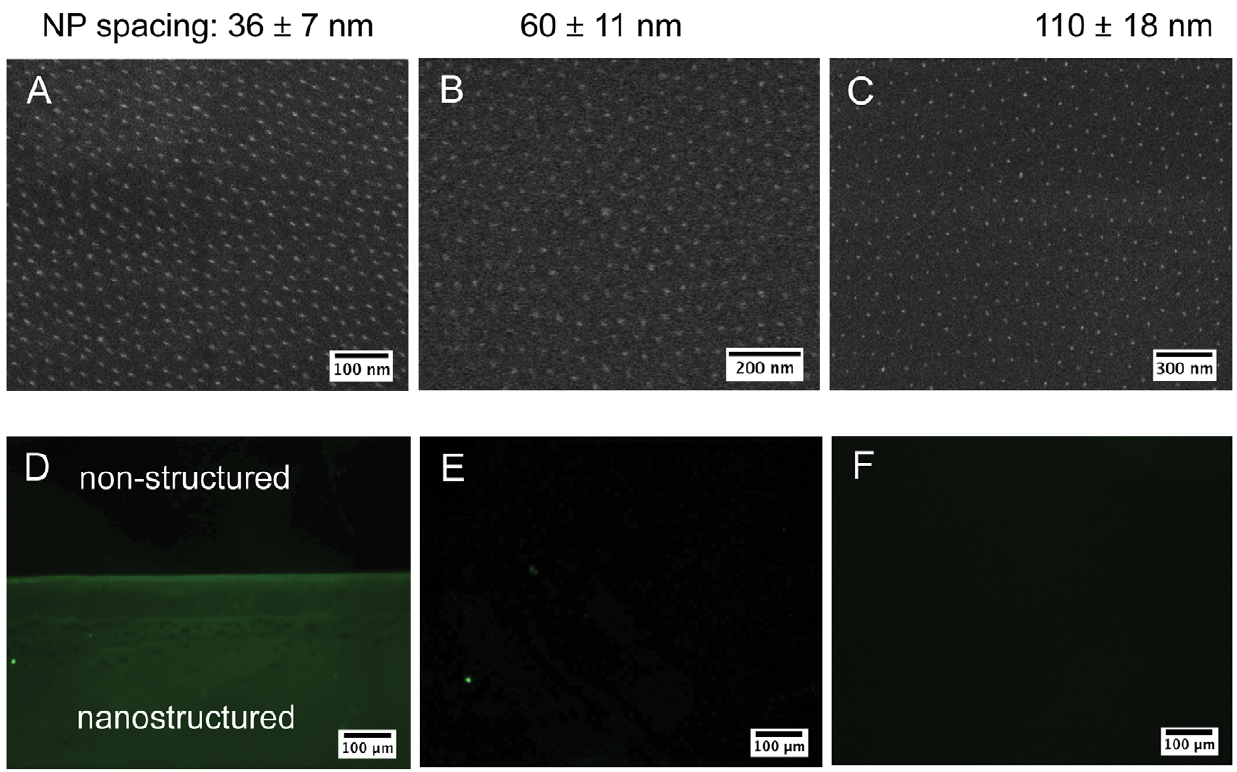
Figure 1. Nanopatterned and biofunctionalized PEG hydrogels. (A–C) Cryo-SEM images of the quasi-hexagonally ordered gold NP patterns on PEG hydrogels with interparticle distances of (A) 36 6 7 nm, (B) 60 6 11 nm and (C) 110 6 18 nm. (D–F) Micrographs of fluorescently labeled, FNRGD-functionalized nanostructured hydrogels. Images of the border between the nanostructured area in the lower part of the micrographs and the unstructured area visible in the upper part are shown. (D) The FNRGD domain on biofunctionalized hydrogels was detected with the help of specific primary antibodies. Controls were produced by (E) substituting nickel with EDTA during functionalization and by (F) omitting the primary antibody during the staining procedure. One representative experiment out of 3 is shown. were biofunctionalized with cRGD, cLDV, FNRGD, OPNs or the non-functional control ligands (cRGE, FN D RGD). Micrographs of KG-1a cells on representative cRGD-, cRGE-, FNRGD- or FN D RGD-functionalized nanostructured hydrogels are shown in Fig. 3A. In general, KG-1a cells exclusively adhered to the nanostructured, rather than the unstructured, area of the hydrogels. Furthermore, adhesion was only observed to the functional ligands cRGD and FNRGD, while adhesion to the control ligands (cRGE, FN D RGD) was negligible to non-existent (Fig. 3A upper panel). KG-1a cells adhered to surfaces with cRGD and FNRGD at 36 6 7 nm interparticle spacing. On surfaces with 60 6 11 nm interparticle spacing KG-1a cells were unable to adhere to cRGD, while adhesion to the FNRGD domain was similar to that on the surfaces with an interparticle spacing of 36 6 7 nm (Fig. 3A lower panel). To compare hematopoietic cell adhesion to nanostructured surfaces varying in interparticle distance and ligand type an assay based on the accurate determination of DNA content was applied. The number of adhering cells was normalized to the number of cells adhering to full-length FN (defined as 100% adhesion). On hydrogels functionalized with cRGD, FNRGD or OPNs at 36 6 7 nm NP spacing, the number of adhering HSPC and KG- 1a cells was comparable to the number adhering to a surface functionalized with the full-length FN protein (100%). On hydrogels functionalized with cLDV cell adhesion was generally lower compared to that of the other adhesive ligands (Fig. 3B, C).